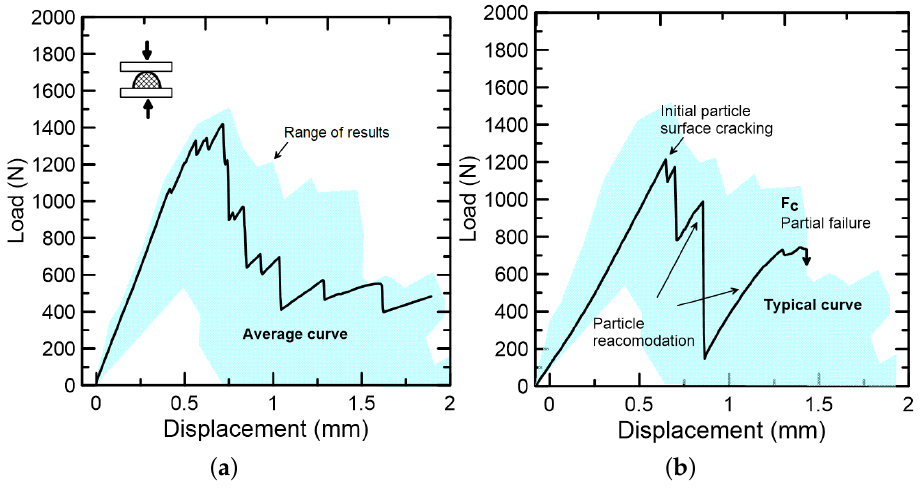
Figure 14. Crushed endocarp submitted to compressive test: ( a ) average curve and range of results, and ( b ) typical curve with mechanical behavior description up to